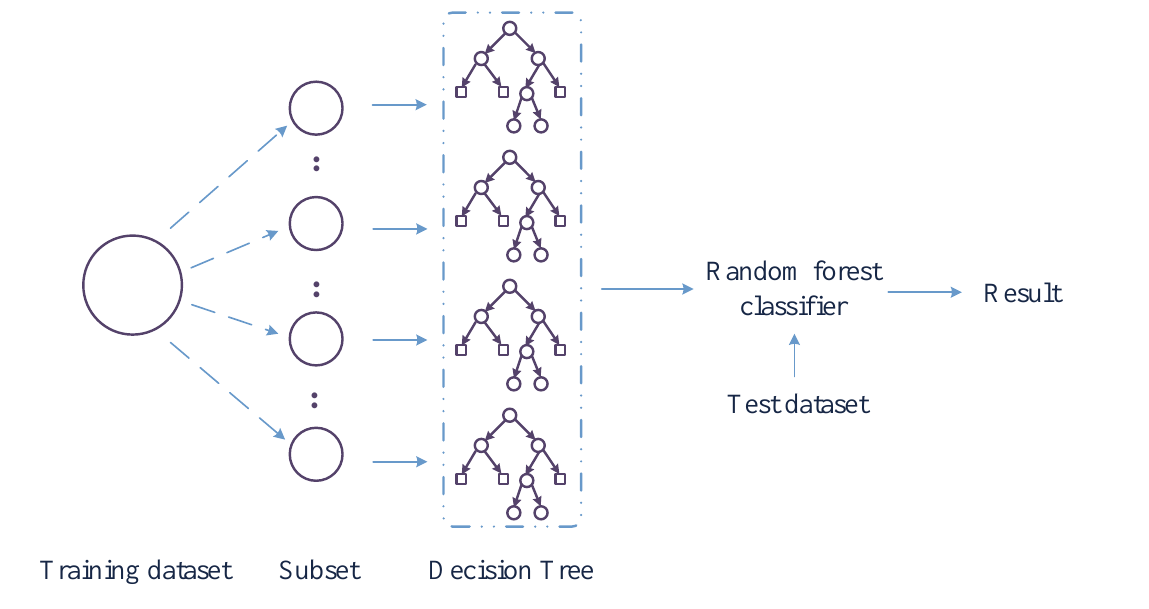
Figure 2. Flow chart of the RF.